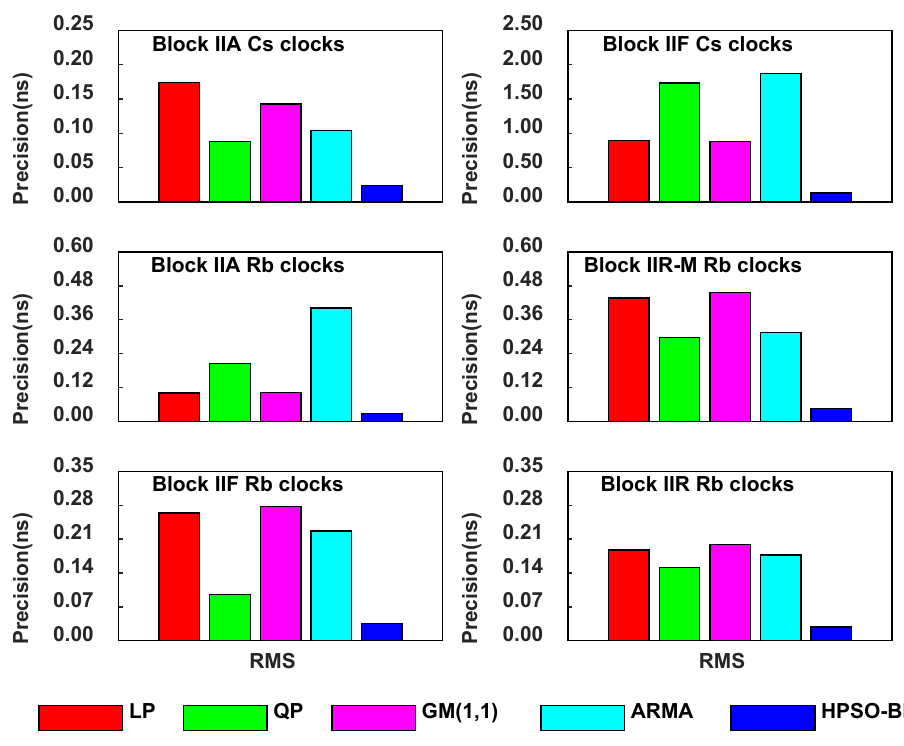
10 of 18 Figure 2. Prediction precision at 20-min and 60-min of five different models for each satellite (Satel- lite 24 is not shown in the figure. Specific results for satellite 24 are shown in Tables 6 and 7). For 18 satellites of different atomic clock types, the HPSO-BP model has the highest prediction precision in the two prediction periods among the five prediction models. Among them, the prediction precision of PRN24 was improved the most. The RMS value of the prediction results of the HPSO-BP model was smaller than that of the other four models, showing that the HPSO-BP model has good performance in the satellite clock